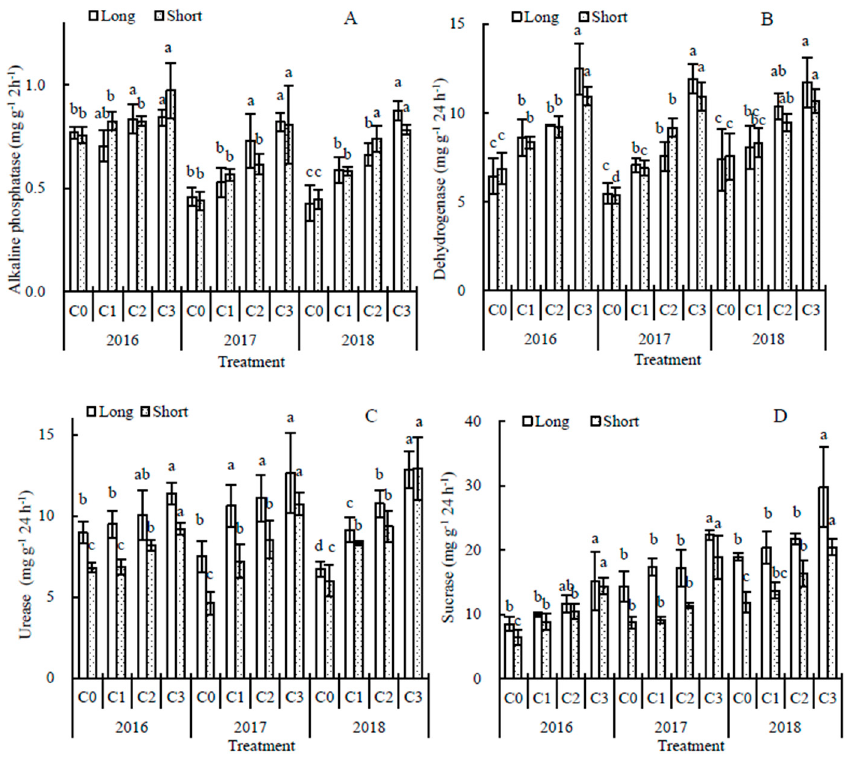
Figure 4. The e ff ect of long- and short-term, increasing biochar application rates [0 (C0), 10 (C1), 20 (C2) and 40 (C3) t ha − 1 ] on ( A ) alkaline phosphatase, ( B ) dehydrogenase, ( C ) urease, and ( D ) sucrase activity. Di ff erent lower-case letters above error bars indicate significant di ff erences between the biochar treatments in either the short- or long-term for a given year ( p < 0.05, LSD post-hoc test). The error bars represent standard deviation of the mean ( n = 3).